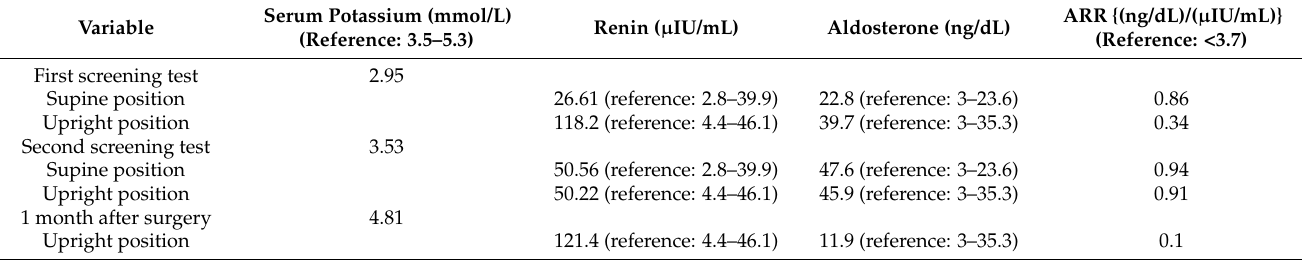
Figure 1. Adrenal contrast-enhanced CT. ( A ) The white arrow showed a round soft-tissue density mass with a diameter of 8 mm; ( B ) The white arrow showed the left inner branch adrenal gland was thickened. CTA showed no stenosis of the bilateral renal arteries and the presence of bilateral renal accessory arteries (pointed by the white arrow in ( C ) and red arrow in ( D )). Table 1. Postural stimulation tests.